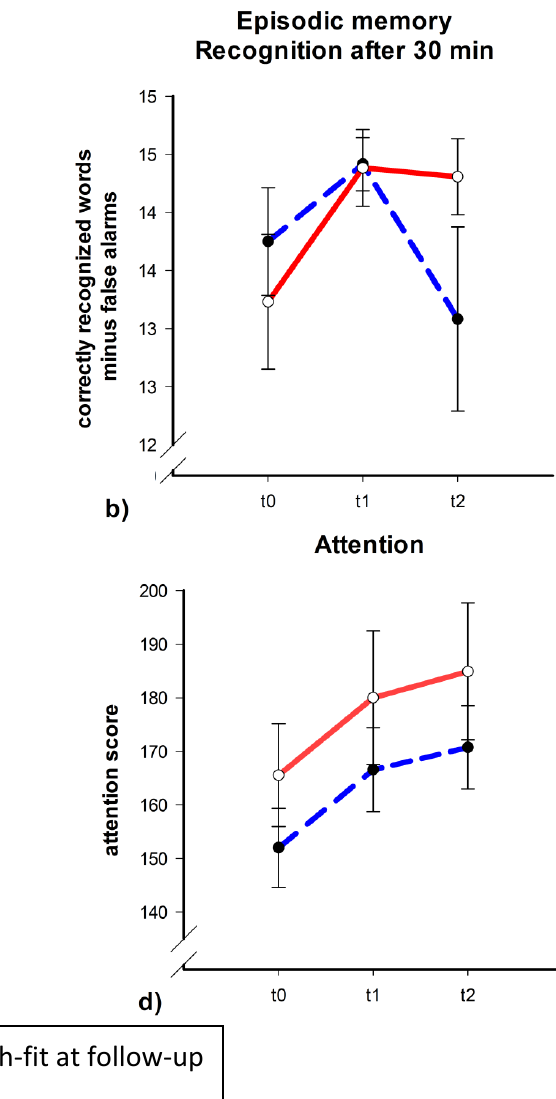
Figure 2. Cardiovascular fitness ( a ), verbal learning (recognition score ( b ) and learning score ( c )), and attention scores ( d ) separately for participants with high fitness (red, solid line) vs . low fitness (blue, dashed line) at follow-up. Mean with standard error